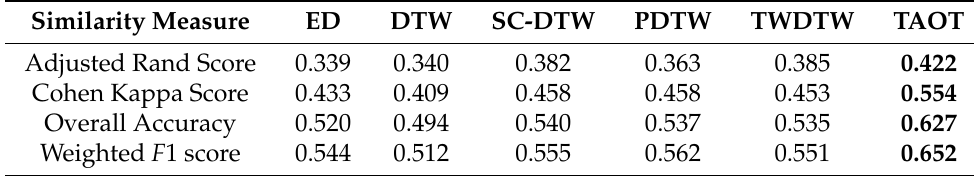
Table 2. Comparison of clustering performance on Reunion Island dataset with averaged initial cluster centers. The best results are shown in